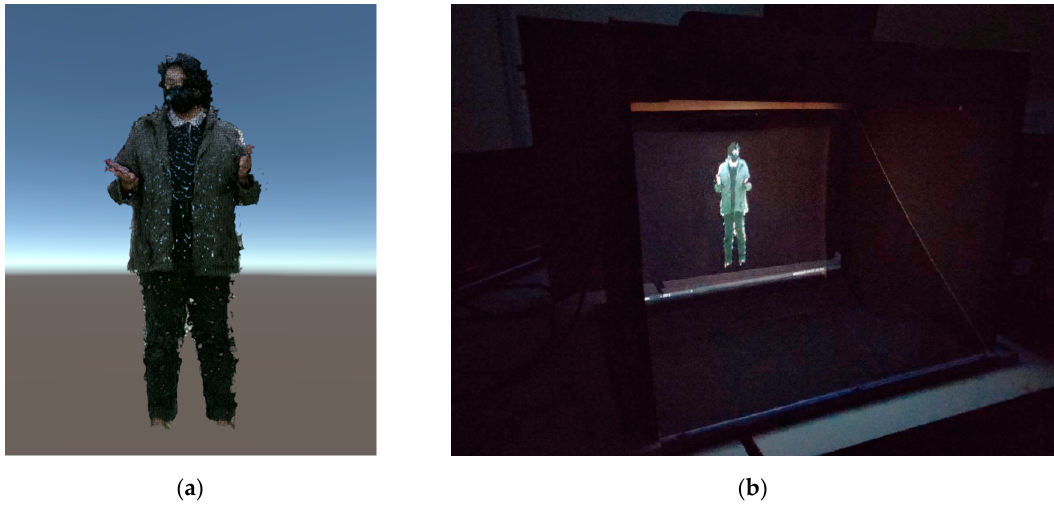
Figure 11. The initial result of displaying the ( a ) reconstructed 3D model of the user ( b ) in Z-hologram.